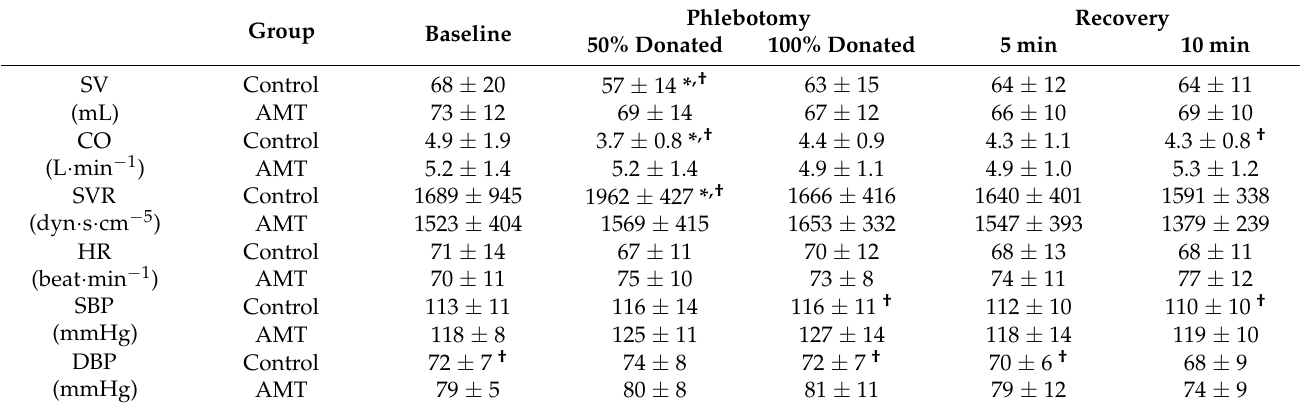
Table 1. Haemodynamic indices and blood pressure during blood